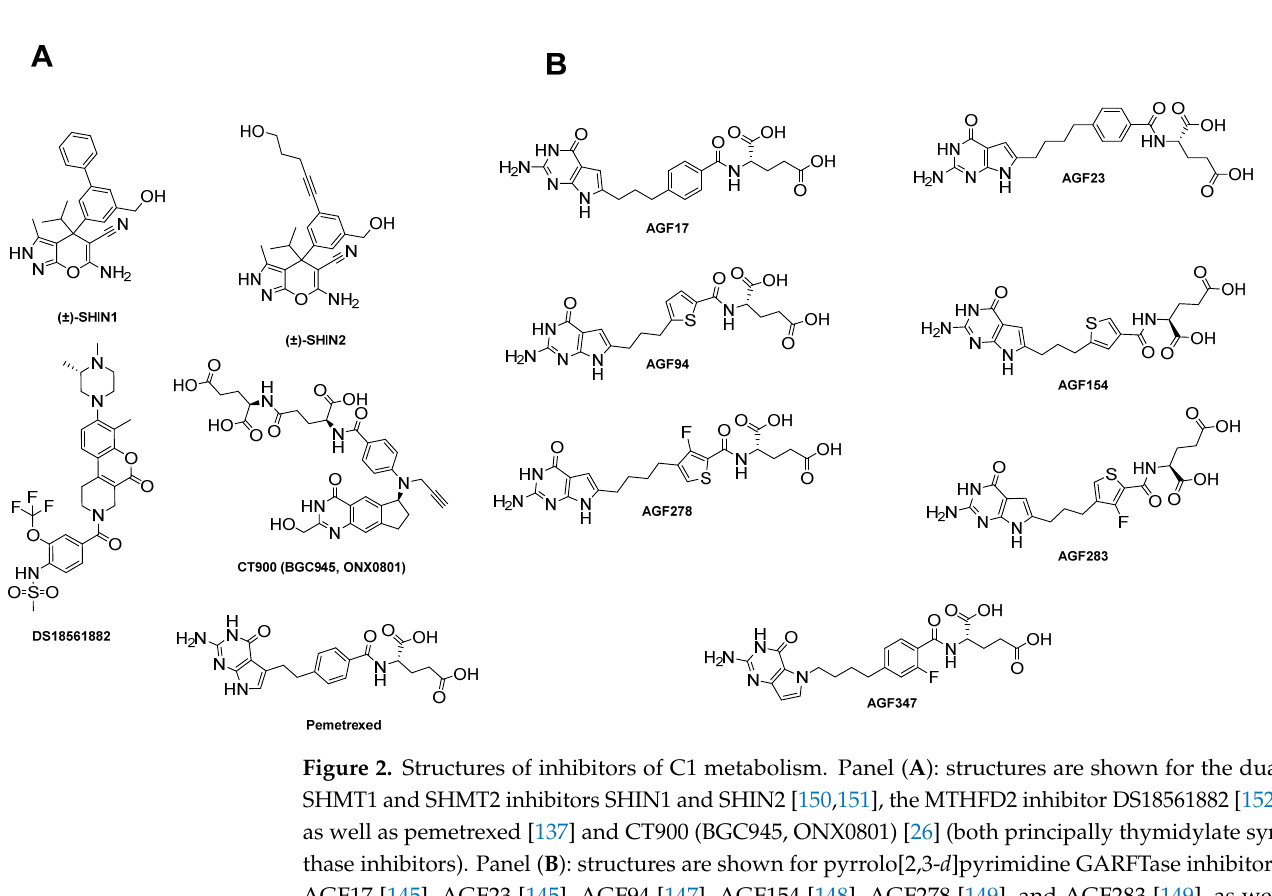
Table 2. FR and PCFT-targeted antifolates.